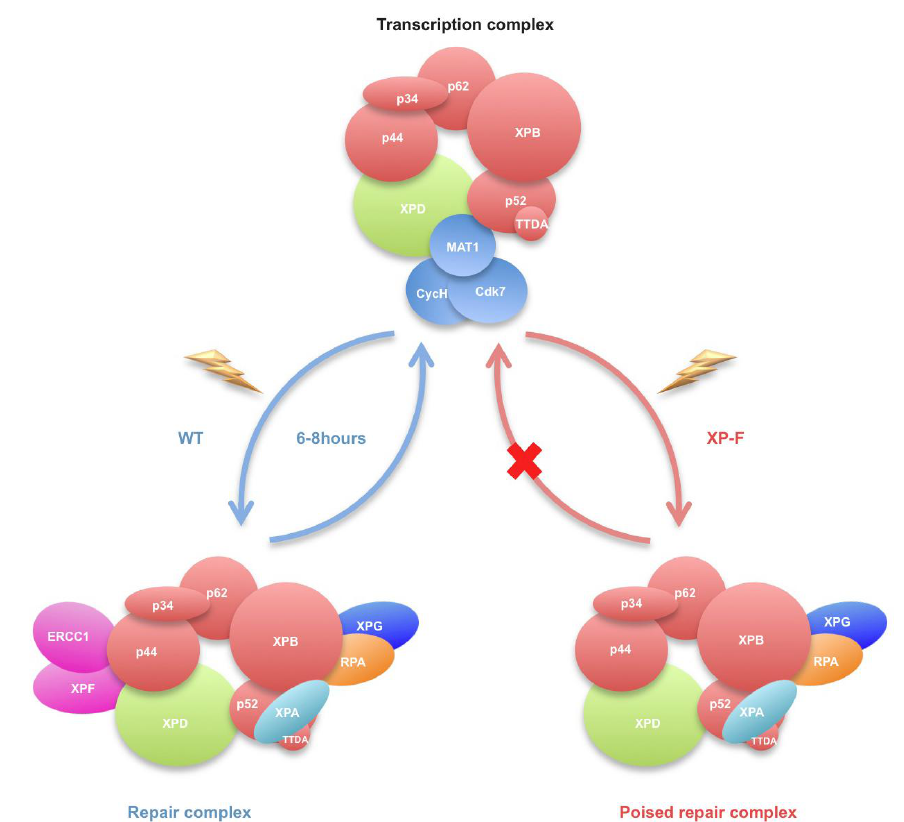
FIGURE 3. The dynamic composition of the TFIIH complex. When TFIIH functions in transcription, it contains ten subunits, including the CAK module. When it functions in repair, it does not contain the CAK module, but associates with various DNA repair factors, including XPA, RPA, XPG, and ERCC1-XPF. In a wild-type cell, the transcription complexes are present without DNA damages. The repair complexes appear following the generation of damages on the DNA and persist until the lesions are removed (6–8 h). Mutations in NER proteins, as found in XP patients (here XP-F), cause an accumulation of intermediate poised repair complexes that can persist in the